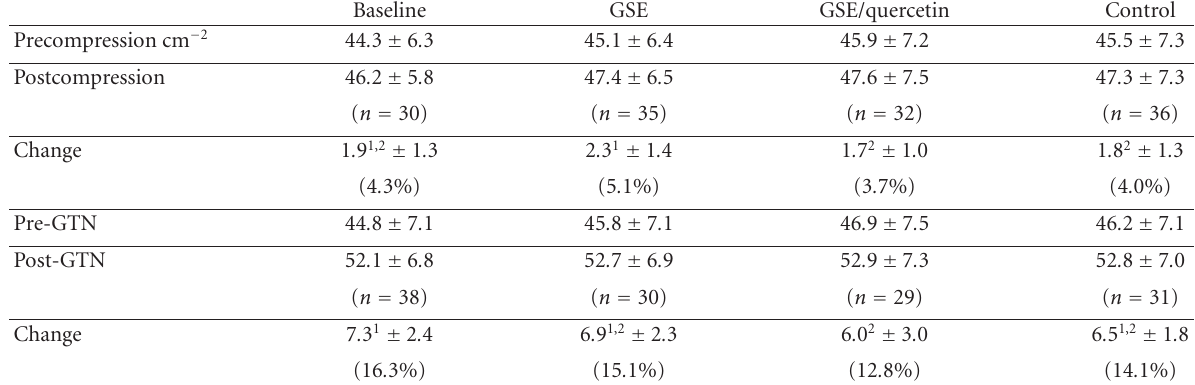
Table 2. Flow-mediated dilatation as measured by ultrasound. N = 35, mean SD. Treatments with di ff erent superscripts are di ff erent at P < . 05.